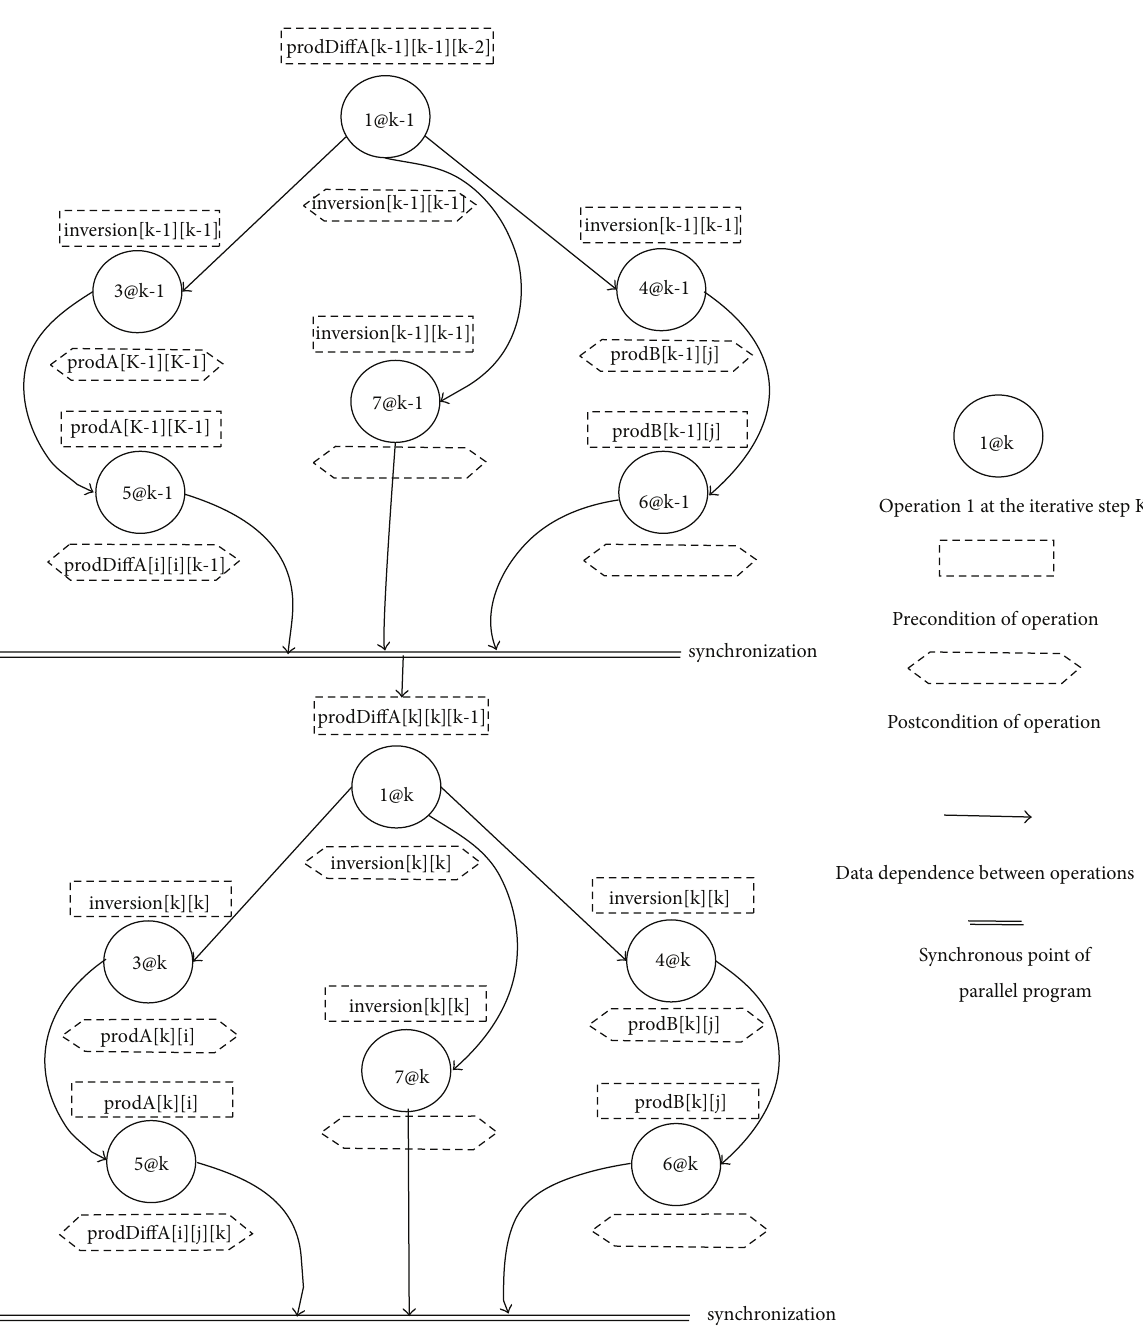
Figure 6: Data transfer model between